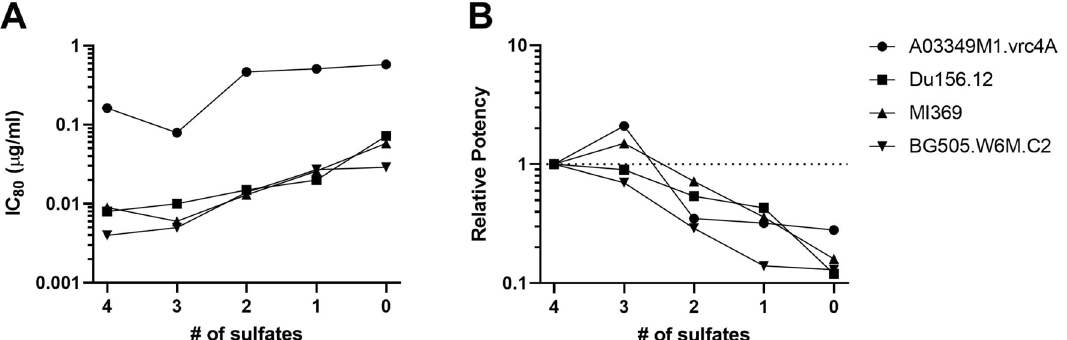
Figure 3. Neutralization potency of CAP256V2LS versus tyrosine sulfation occupancy. Sulfation fractions from CHO clone 206 were assayed in one experiment for neutralization activity against 4 Env-pseudoviruses, ( A ) IC 80 and ( B ) relative neutralization potency of each virus, calculated as the IC 80 of the 4-SO 3 proteoform divided by the IC 80 of the tested fraction.